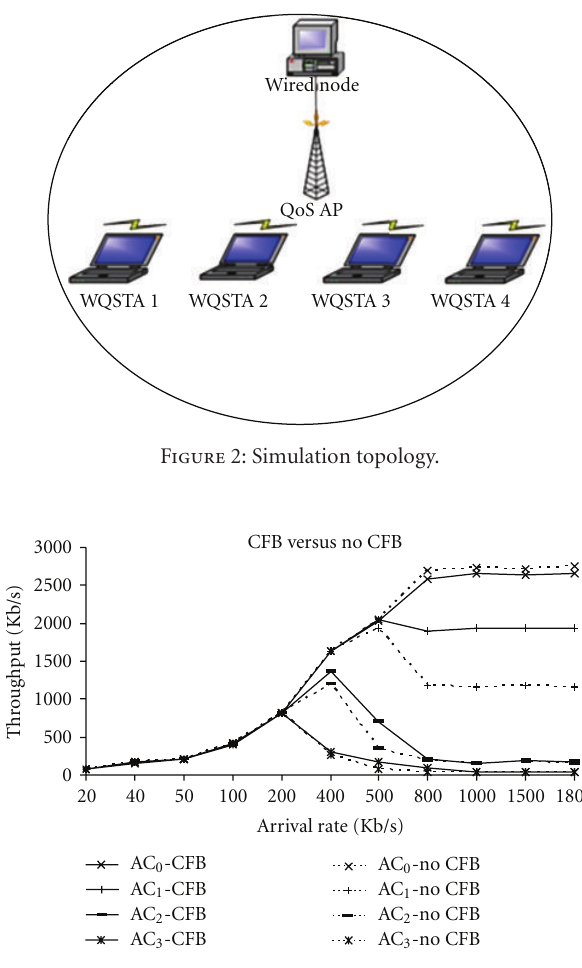
Figure 3: E ff ect of CFB on the achievable throughput per